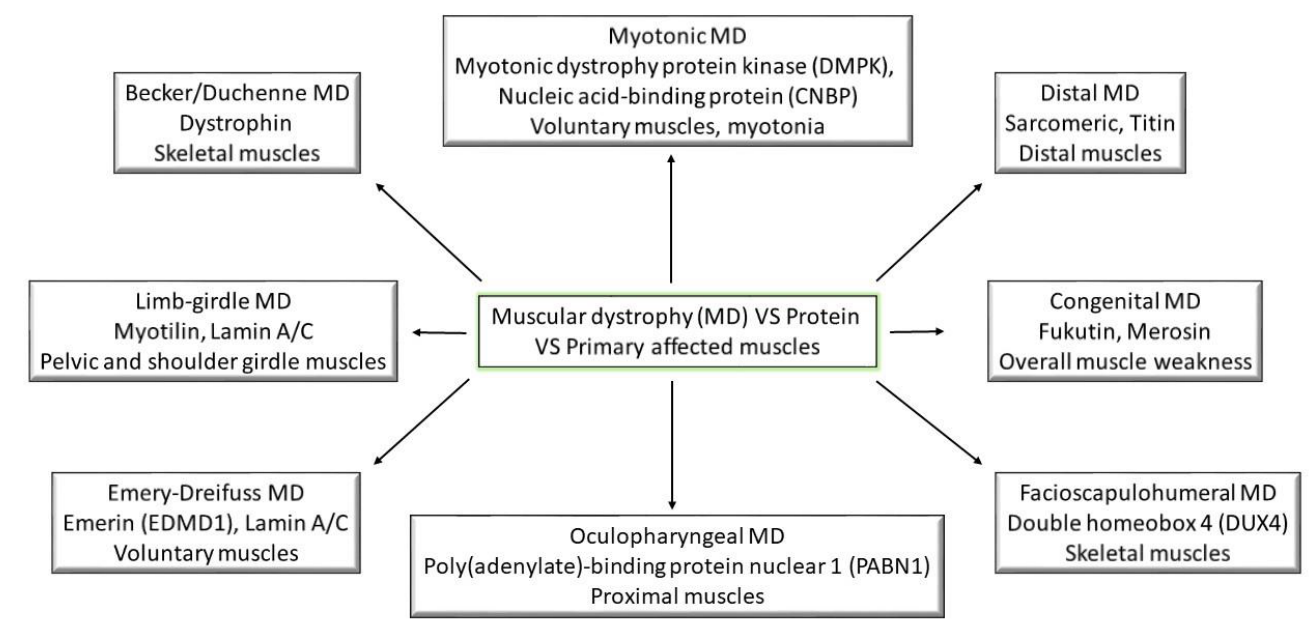
Figure 1. Muscular dystrophies and their primary affected proteins and muscles; (MD—muscular dystrophy).